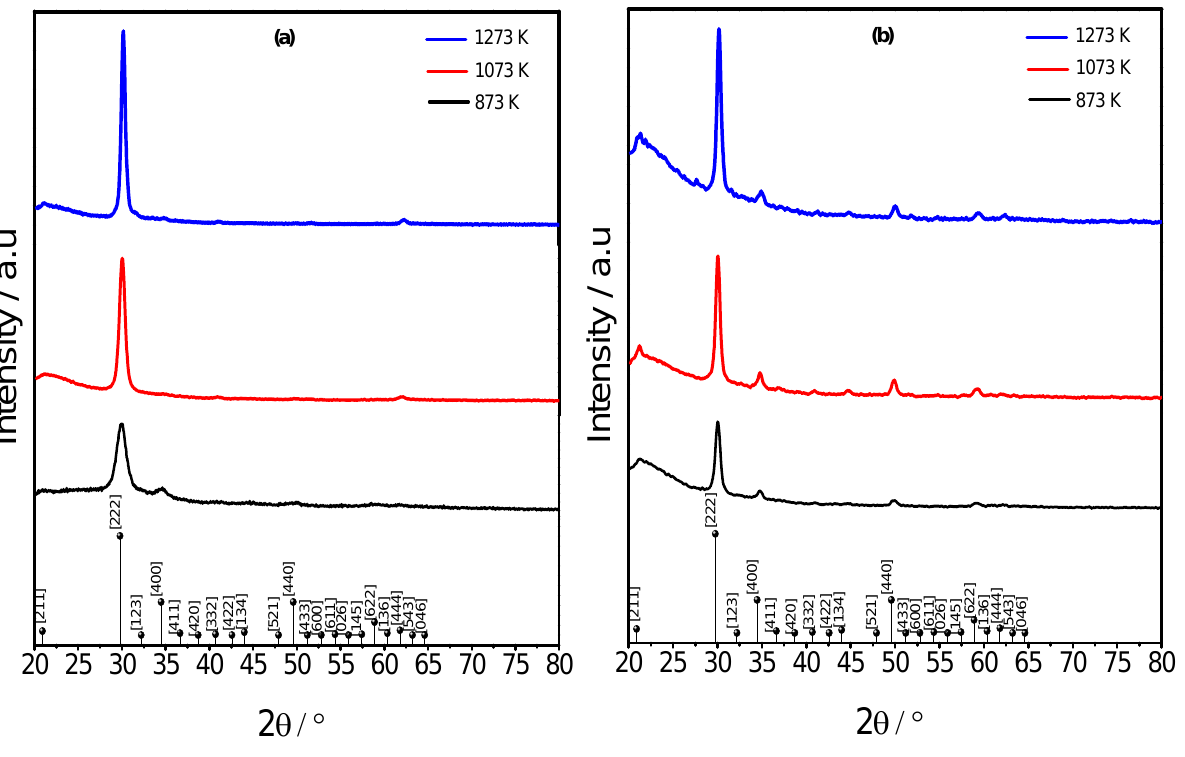
O :Eu 3+ F127 modified thin films. ( a ) F127/Lu=1.0; 2 3